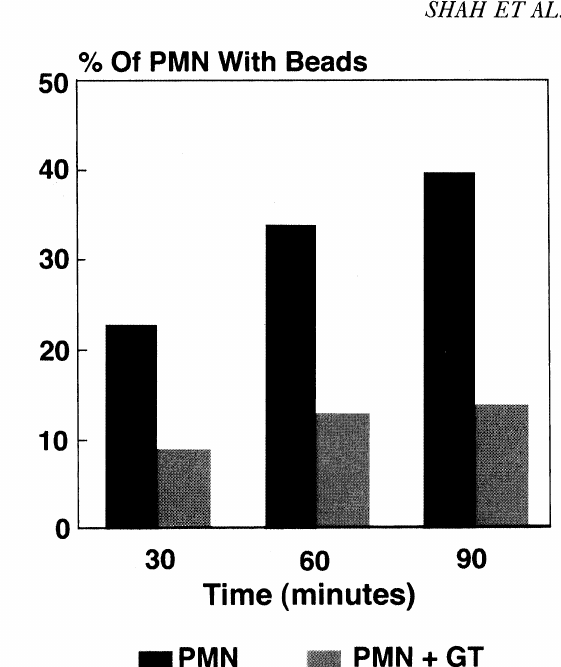
Fig. 5. Particle engulfment by gliotoxin-treated (I IJg/mL) PMN. A PMN suspension (gliotoxin-treated [GT] and -un- treated) was adjusted to Ix 106 cells/mL. The cells were co-incubated with fluorescein-conjugated beads (I x 108 cells/mL) at 37C for 30 to 90 minutes. The effect of glio- toxin on particle uptake by PMN was investigated by flow